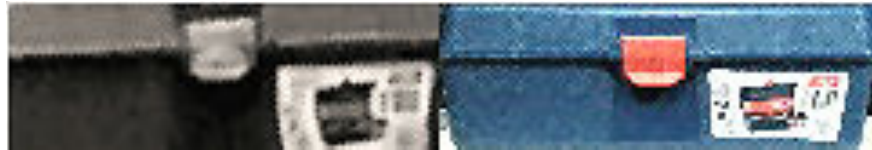
Figure 14. Experiment 1,